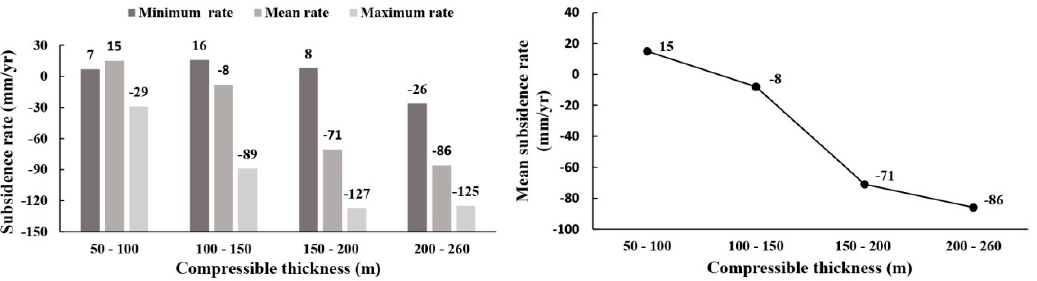
Figure 11. Distribution of land subsidence rate in the different compressible thickness layers.